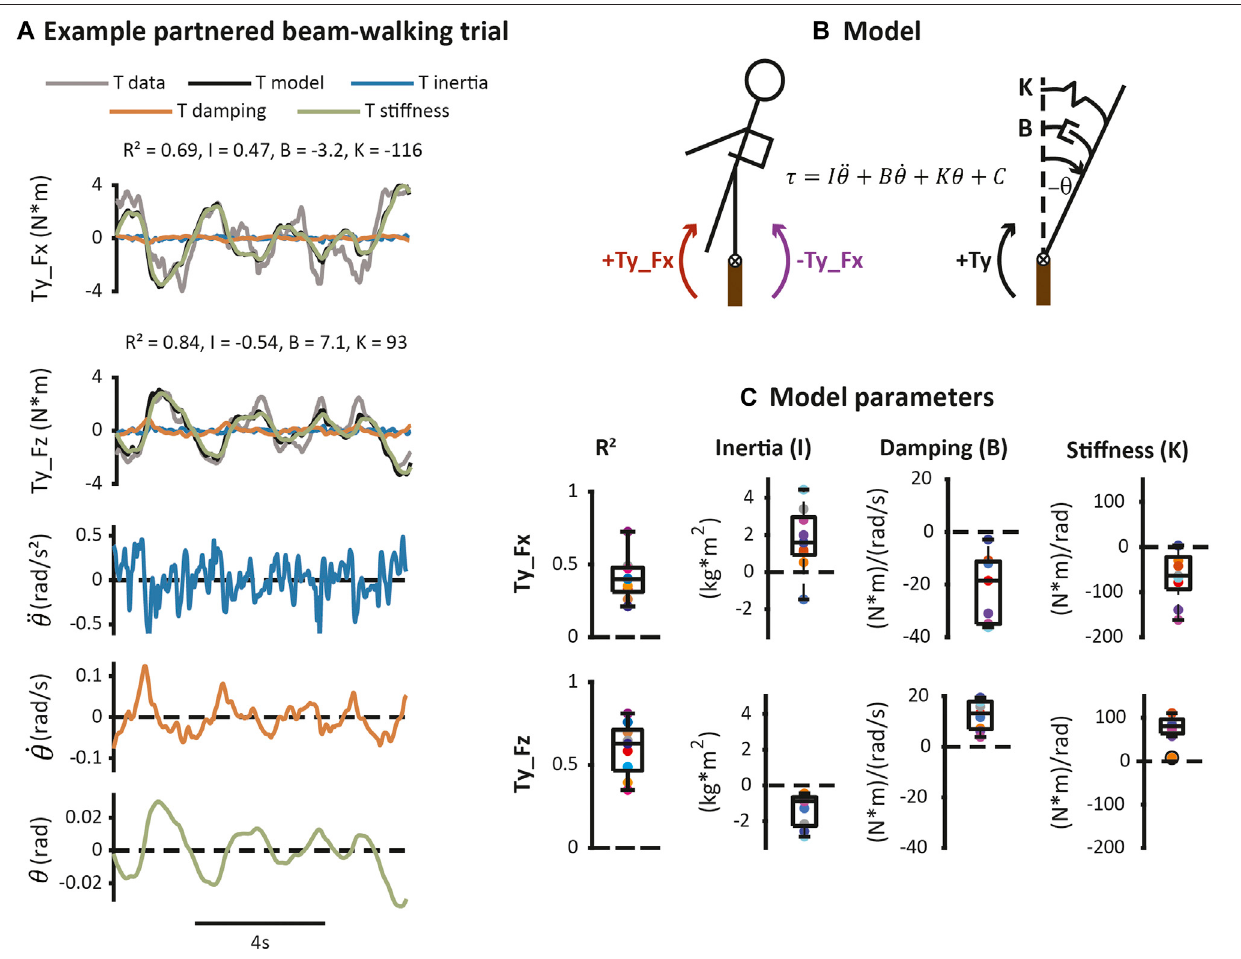
FIGURE 7 | Model of relationship between torque and beam-walker ’ s body motion. Error bars represent ± one standard deviation. (A) Example data from partnered beam-walking trial. (B) A mass-spring-damper model was fi t between the beam-walker ’ s angular torso state and each torque component (Ty_Fx and Ty_Fz) separately. (C) Coef fi cients of mass-spring-damper model. Top row corresponds to torque due to lateral hand forces (Ty_Fx), and bottom row corresponds to torque due to vertical hand forces (Ty_Fz). Columns show values of quality of fi t, inertia, damping, and stiffness. Boxplots show group data, while a different color dot denotes each partnership. Dots with black outlines are